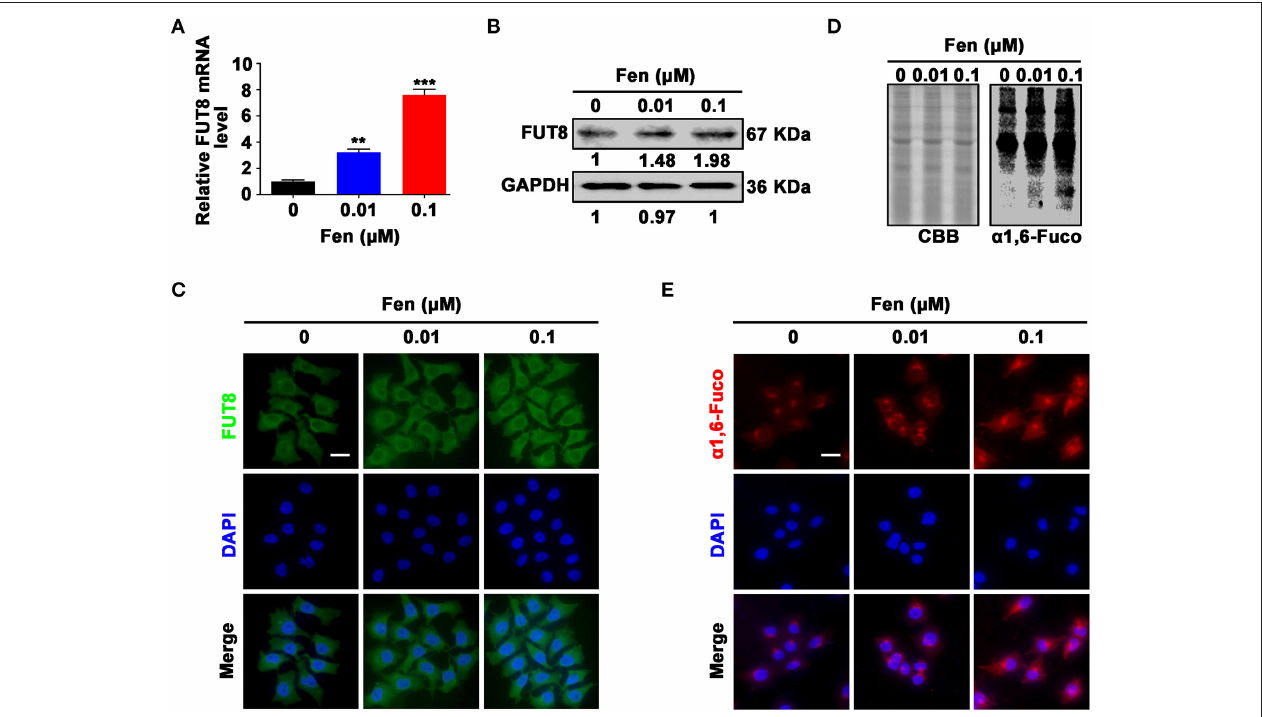
FIGURE 3 | Fentanyl upregulates FUT8 expression and α 1, 6-fucosylation level in MCF-7 cells. (A) qPCR analysis of FUT8 gene expression. (B) Western blot analysis of FUT8 protein expression. (C) Representative immunofluorescent images of FUT8 expression. (D) Lectin blot analysis of α 1, 6-fucosylation level. Coomassie brilliant blue (CBB) was used as a loading control. (E) Lectin fluorescent staining of α 1, 6-fucosylation expression. (Scale bars = 50 µ m; Magnification, 400 × ). Data are represented as mean ± SD ( n = 3). Statistical significant different in gene expression (** P < 0.01; *** P <